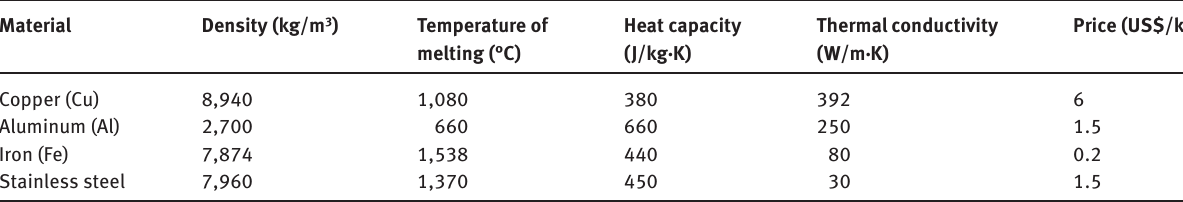
than the maximum temperature of the TES) even if it is